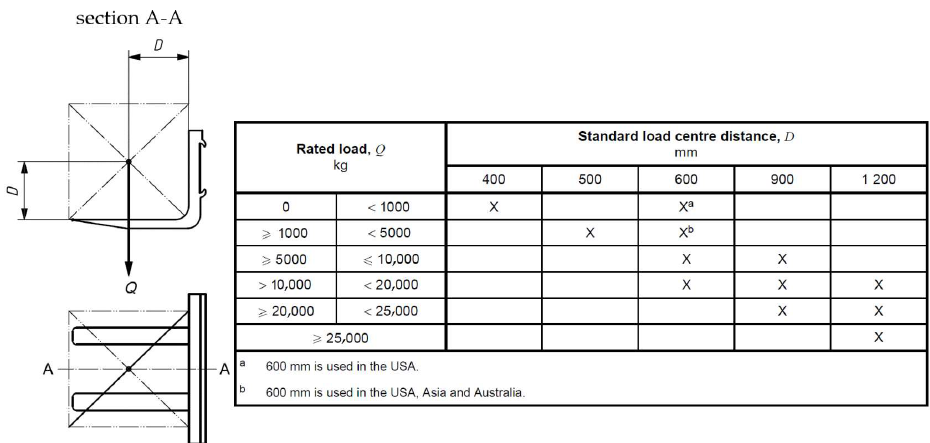
Figure 1. Standard load centre distance.